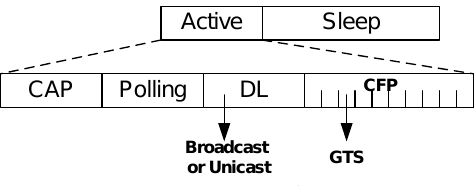
Figure 3. Active period